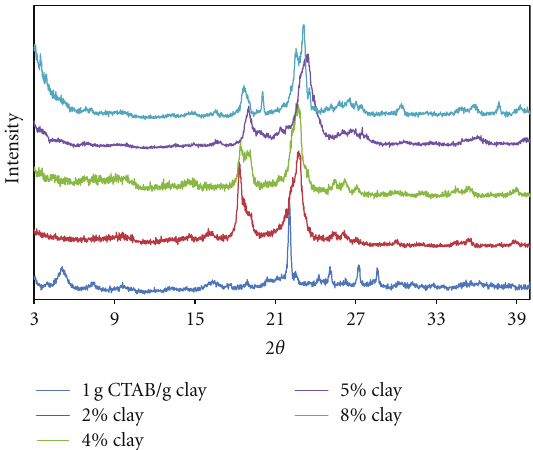
Figure 5: XRD patterns for produced PEO/clay nanocomposites at various clay compositions (1.0 g CTAB/g clay ratio).